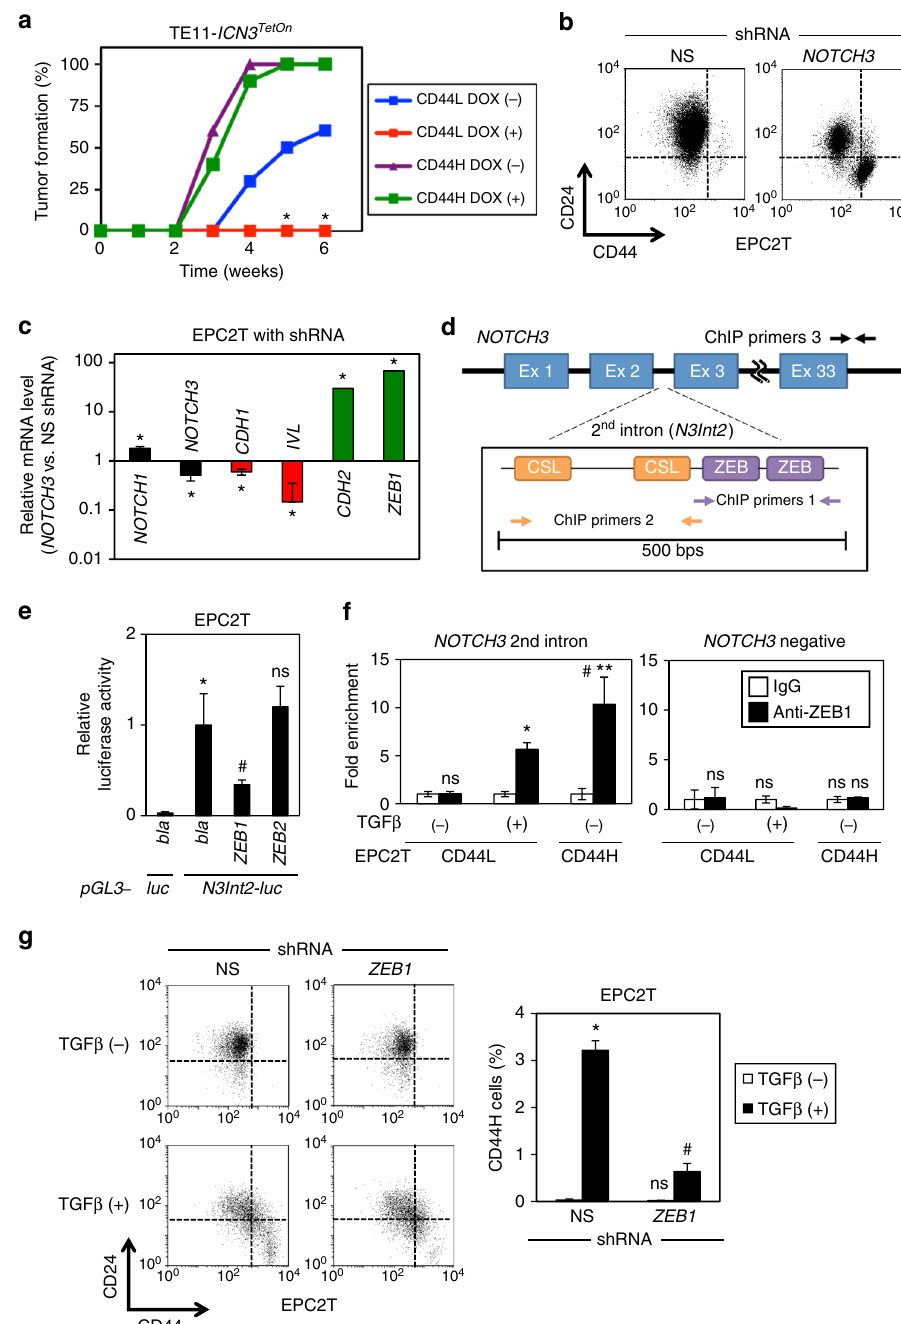
Fig. 6 ZEB1 represses NOTCH3 , facilitating EMT and tumor initiation. a Serial transplantation experiments with DOX-inducible ICN3I- expressing TE11 (TE11- ICN3 TetOn ). Tumor formation rates were determined as in Fig. 2e. * P < 0.05 vs. CD44L and DOX ( − ); n = 10. b Representative fl ow cytometry scatter plots of EPC2T cells with NOTCH3 -targeted or non-silencing (NS) control shRNA. NOTCH3 shRNA increased CD44H cells (lower right quadrant) to 29.8 ± 0.4% s.d. as compared to 0.4 ± 0.1% s.d. in NS control ( P < 0.0001 by Student ’ s t -test, n = 3). c qRT-PCR analysis for indicated genes comparing EPC2T cells with or without NOTCH3 knockdown. mRNA level for each gene in NS control cells was set to 1. * P < 0.05 vs. NS, n = 3. d Schematic of NOTCH3 second intron ( N3Int2 ) region and ChIP PCR primers in f and Supplementary Fig. 4e. Primers amplify the region lacking ZEB1 or CSL-binding sites. e Transfection assays for pGL3-N3Int2-luc reporter activity with or without ectopic ZEB1 or ZEB2 expression. bla , empty vector control for ZEBs. * P < 0.05 vs. bla and pGL3- luc (empty reporter); # P < 0.05 vs. bla and pGL3-N3Int2-luc ; ns not signi fi cant vs. bla and pGL3-N3Int2-luc ; n = 4. f ChIP assays for ZEB1 binding to N3Int2 region in puri fi ed CD44L and CD44H cells. CD44L cells were stimulated with TGF β for 14 days to induce CD44H cells. * P < 0.0005 vs. CD44L and IgG and TGF β ( − ); # P < 0.005 vs. CD44H and IgG and TGF β ( − ); ** P < 0.05 vs. CD44L and anti-ZEB1 and TGF β (+); ns not signi fi cant vs. IgG and TGF β ( − ); n = 3. g Representative fl ow cytometry scatter plots of EPC2T cells with ZEB 1-targeted or NS control shRNA. * P < 0.05 vs. NS and TGF β ( − ); # P < 0.0001 NS and TGF β (+); ns not signi fi cant vs. NS and TGF β ( − ); n = 3. In b , g , fl ow cytometry was done 7 days following lentivirus infection. All bar diagrams represent mean ± s.d. At least three independent replicates were performed for all experiments. Fisher ’ s exact test was used for percentage comparisons in a . Student ’ s t -test was used for paired data comparisons in b , c , f . ANOVA with Tukey ’ s post hoc test was used for multiple comparisons in e , g NATURE COMMUNICATIONS | 8: 1758 | DOI: 10.1038/s41467-017-01500-9 |